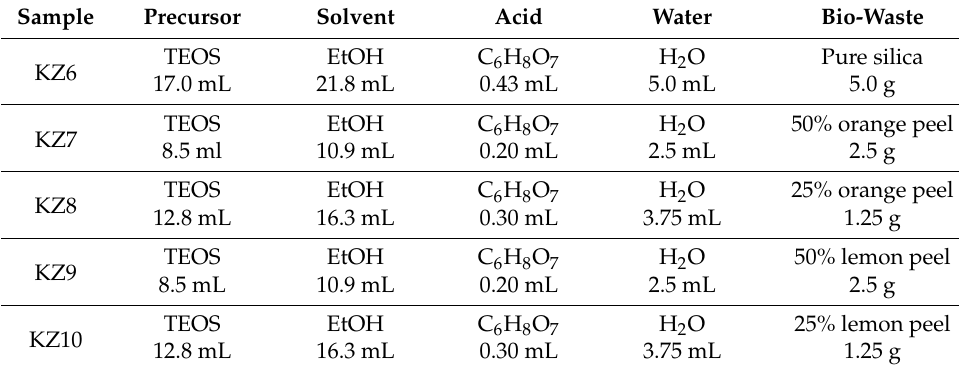
Table 2. Conditions employed in silica synthesis using citric acid as a catalyst.